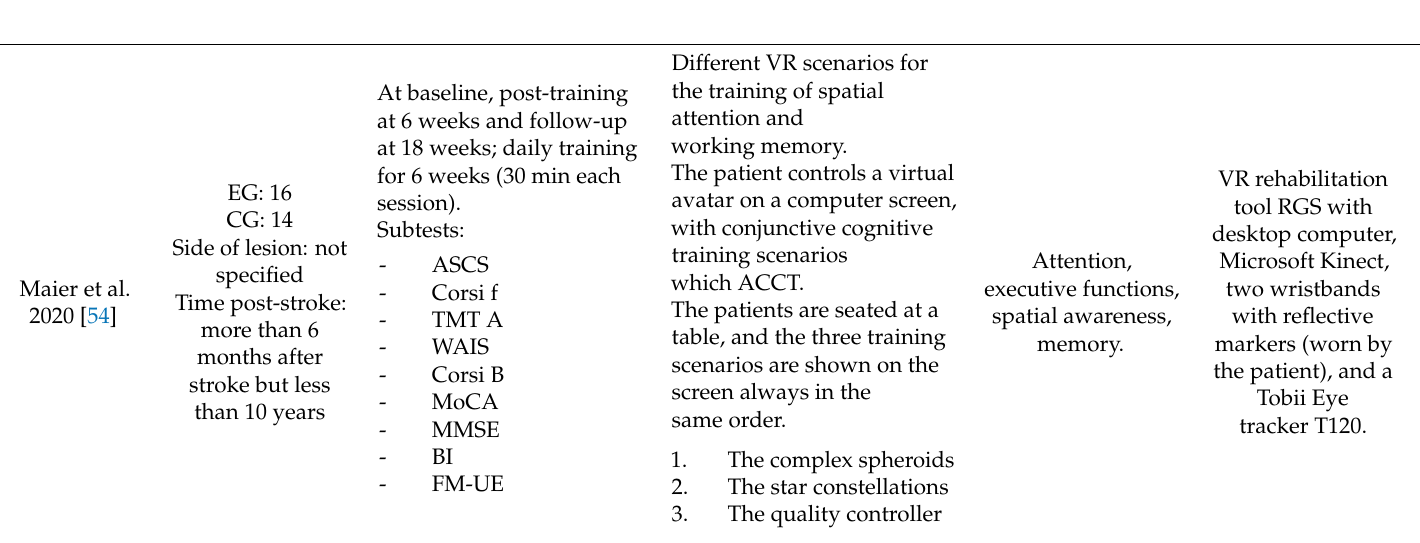
The patients are seated at a table, and the three training scenarios are shown on the screen always in the same order. 1. The complex spheroids 2. The star constellations 3. The quality controller